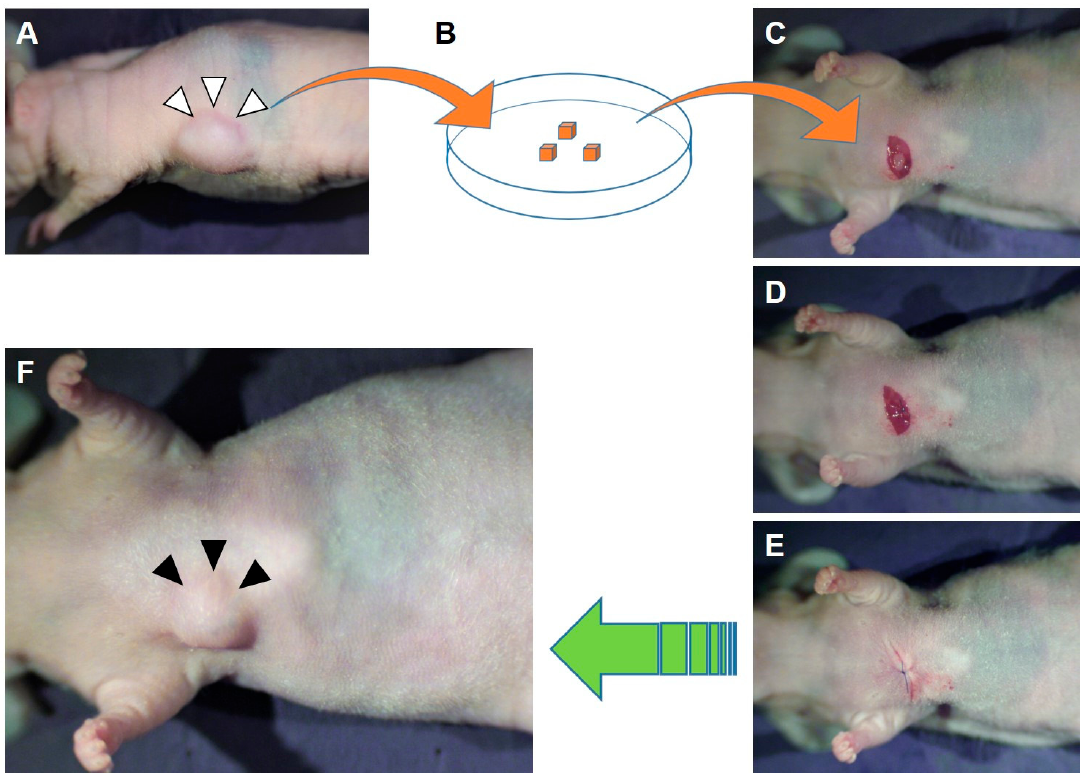
Figure 1. Procedures to establish a Ewing’s sarcoma patient-derived orthotopic xenograft (PDOX) model. A subcutaneously grown patient-derived Ewing’s sarcoma was resected ( A ) and cut into small fragments on a dish ( B ). A 7 mm skin incision was made on the right chest wall and then a single tumor fragment was implanted orthotopically into the layer between the pectoral and intercostal muscles in the right chest wall of nude mouse ( C ). After the pectoral muscle was closed by 6–0 nylon sutures ( D ), the skin incision was sutured ( E ). ( F ) The established PDOX model 4 weeks after the orthotopic implantation [28]. White arrowheads indicate the subcutaneously grown tumor. Black arrowheads indicate the established PDOX tumor.